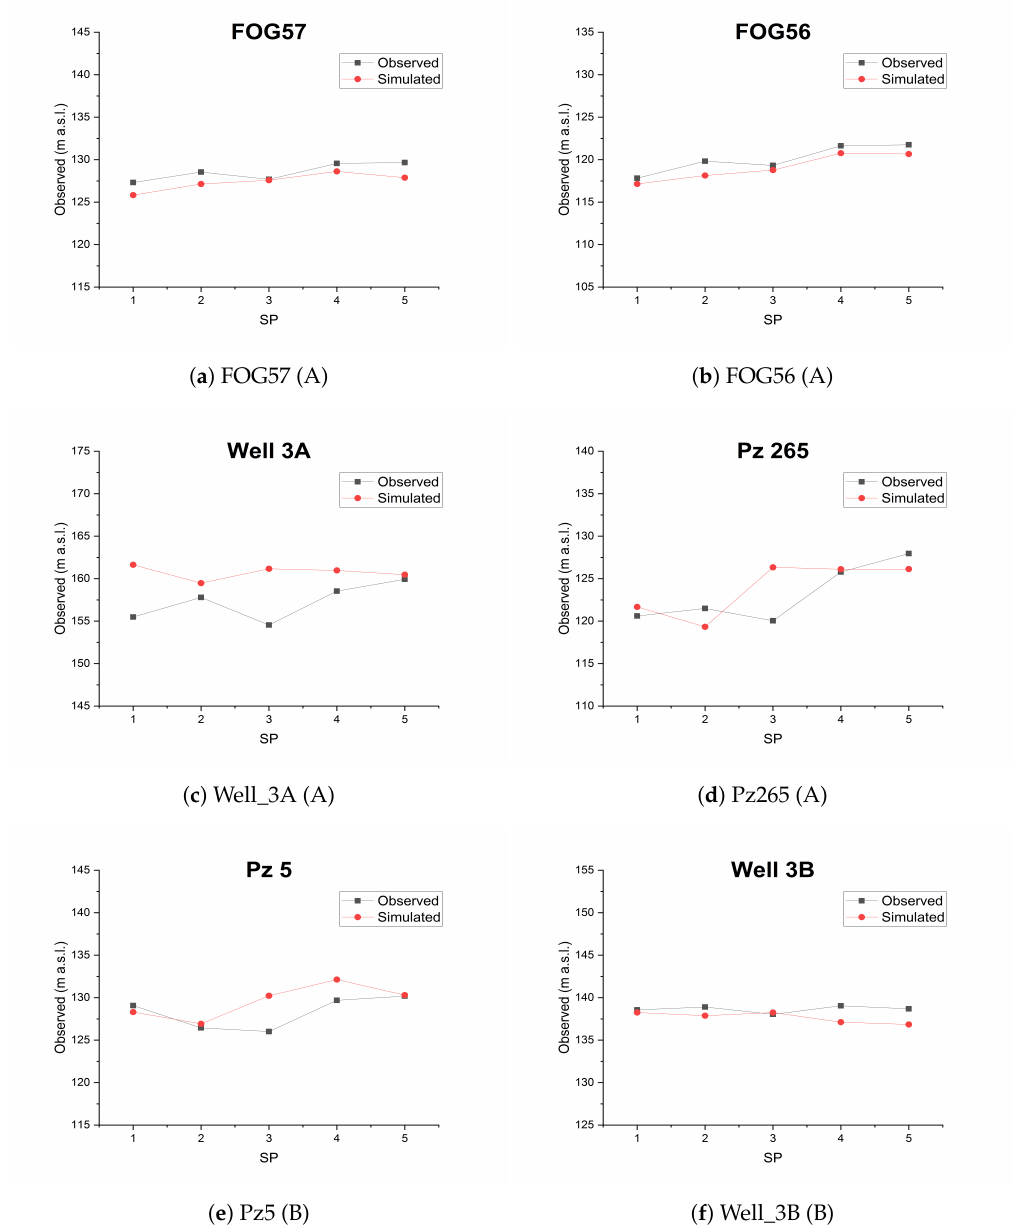
Figure 7. Comparison between observed and calculated hydrographs (presented in Figure 6 for some monitoring points in the domain: ( a ) FOG57, ( b ) FOG56, ( e ) Pz5 are located within the area of interest while ( c ) Well_3A, ( d ) Pz265, and ( f ) Well_3B are outside the area. A and B in brackets indicate the screened